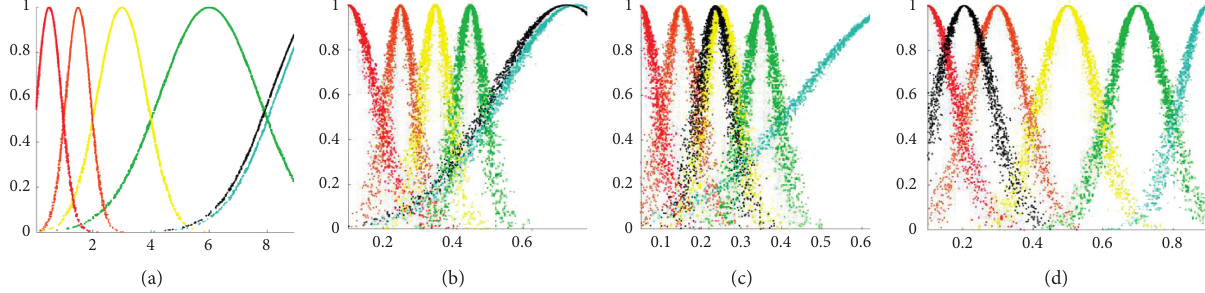
Figure 11: Cloud figures of economic vulnerability (Blue for Level, I Green for Level II, Yellow for Level III, Brown for Level IV, Red for Level V, and Black for assessment value). (a) x 101 . (b) x 102 . (c) x 103 . (d) x 104 .